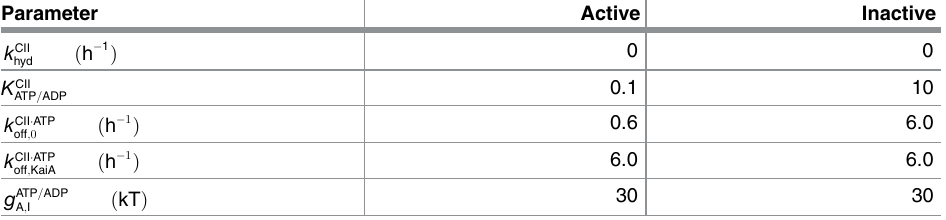
Table 5. Parameters used in the alternative model without hydrolysis in the CII domain that are differ- ent from the values in our original model in Tables 2 and 3. Parameters values are listed for both the active and inactive conformations if they have been changedfor either